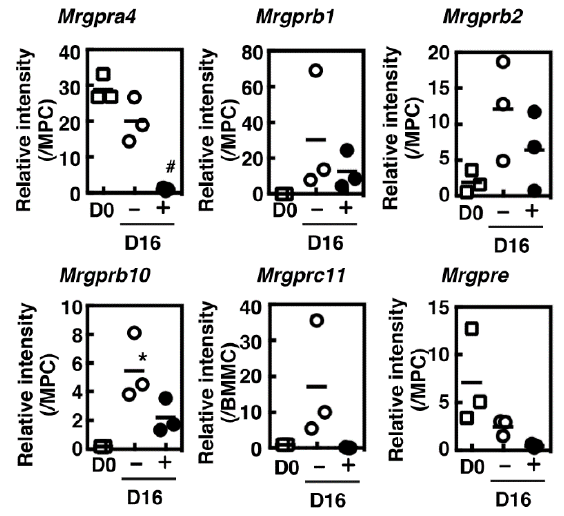
circles) or absence ( − , open circles) of 1 µ M dexamethasone were densitometrically determined (n = 3). Values with ** p < 0.01 (vs. D0) and # p < 0.05 (vs. D16, ( − )Dex) are regarded as significant.